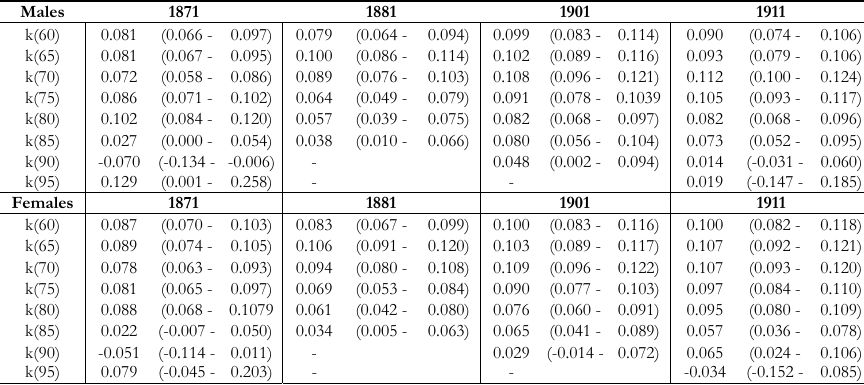
Estimates of k(x) (95% CI) in the period